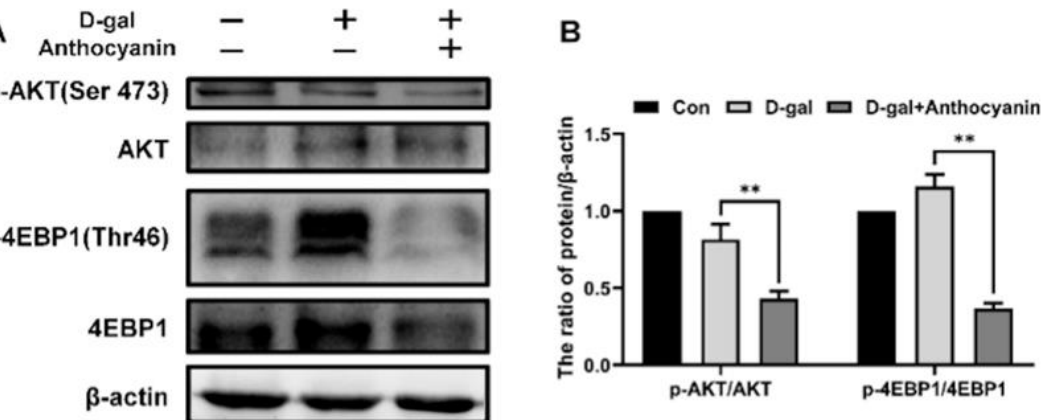
Figure 4. Anthocyanin inhibited the PI3K/Akt/mTOR signaling pathway of senescent cells. ( A , B ) Cells were treated with 40 mM D-galactose alone or in combination with 40 μg/mL anthocyanin for 72 h, and the expression of p-AKT/AKT, p-4EBP1/4EBP1 were measured by western blot. Data are presented as mean ± SD, n = 3. ** p < 0.01.